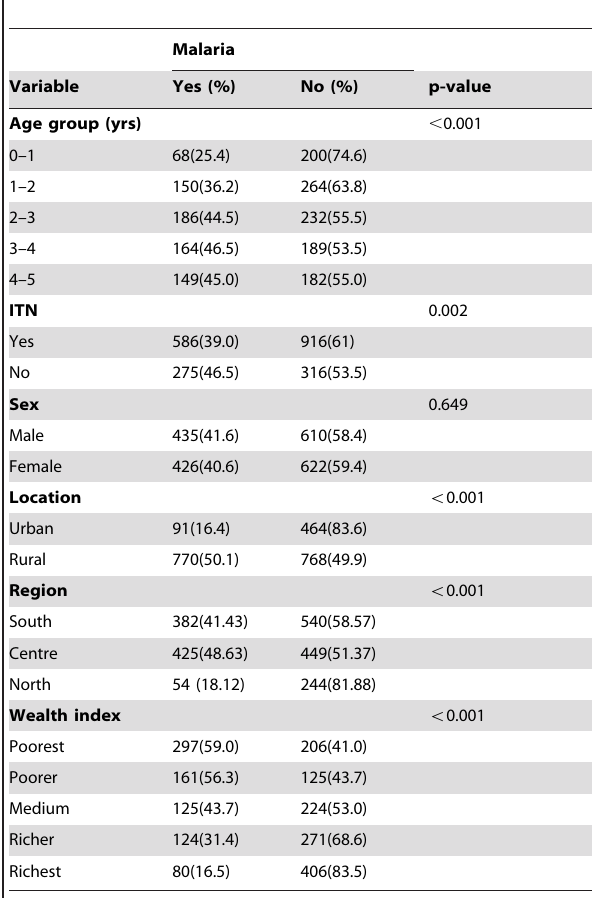
Table 2. Association between malaria risk and selected categorical